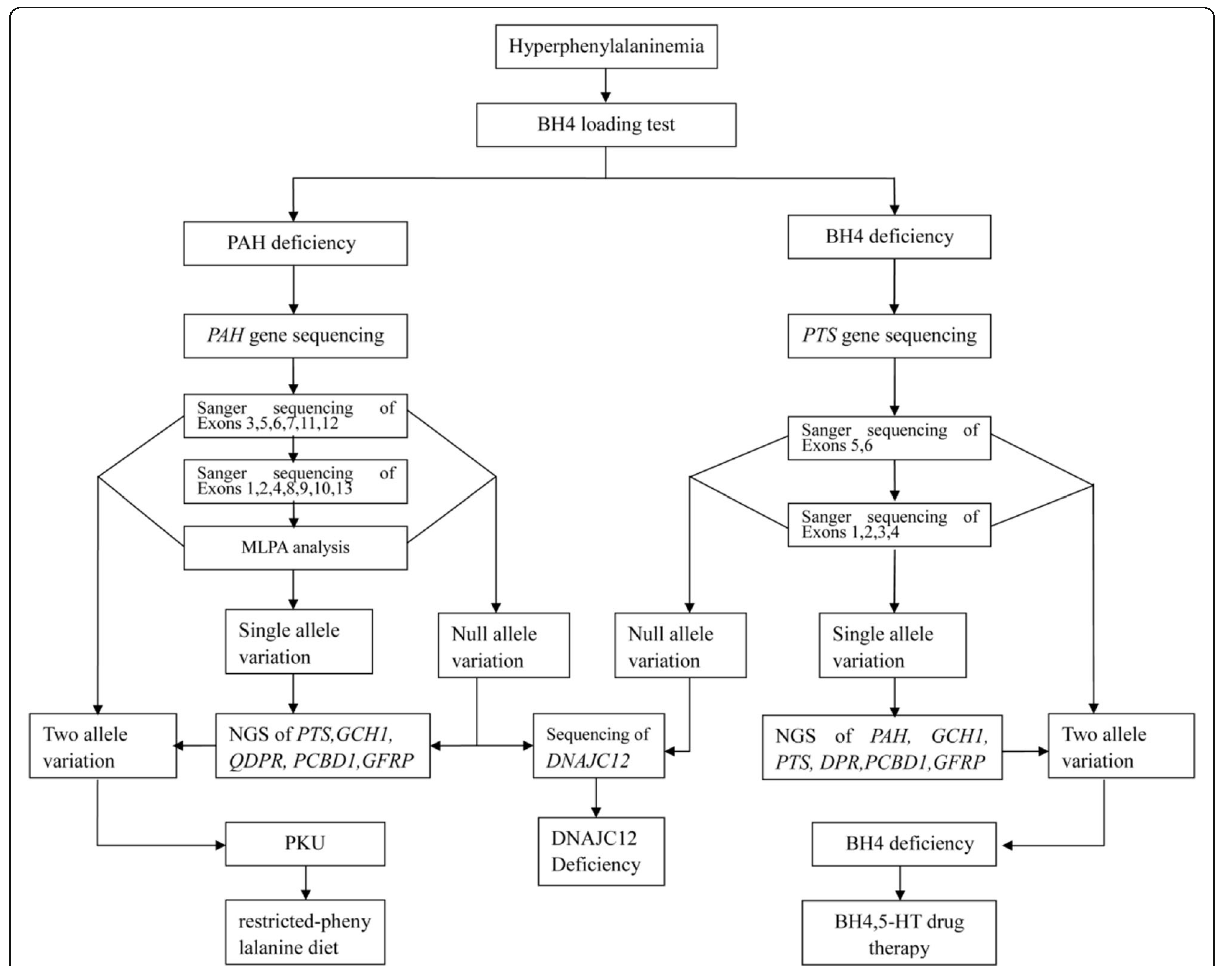
Fig. 1 Flow chart depicting the strategy used for gene diagnosis in hyperphenylalaninemia